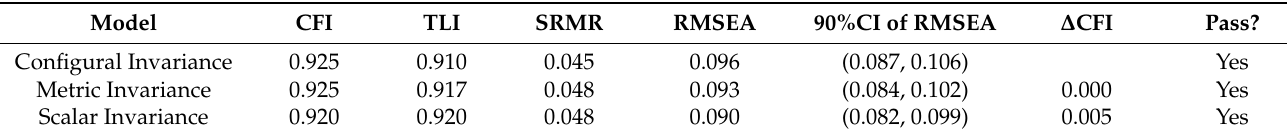
Table 8. Measurement Invariance of